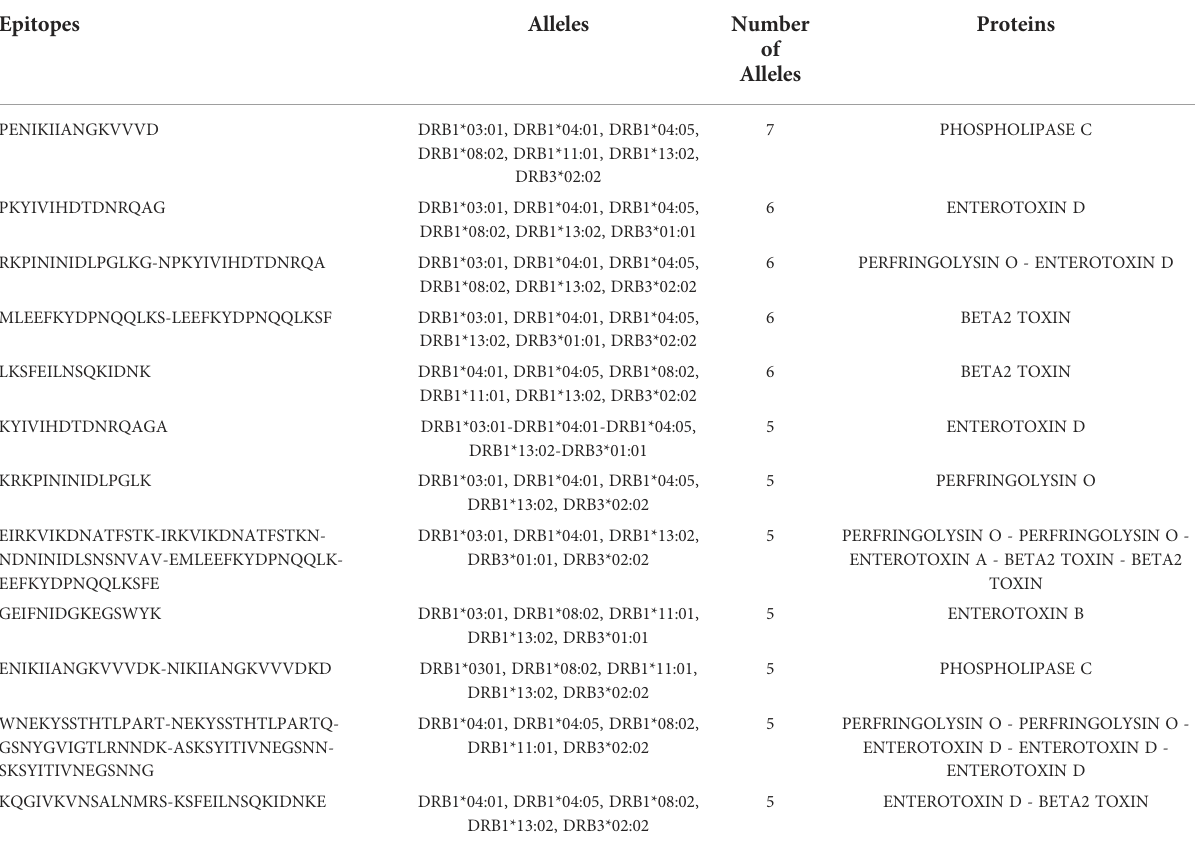
TABLE 1 Promiscuous HTL-epitopes in C. perfringens toxins. Epitopes Alleles